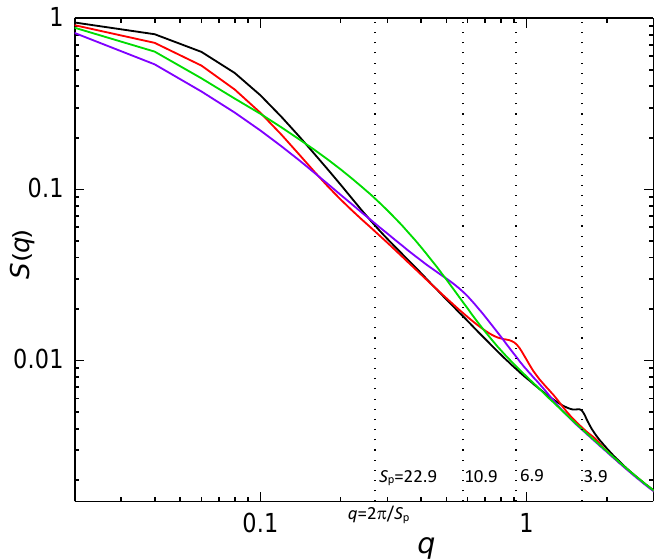
Figure 10. Structure factor for a flexible block of a block copolymer in an array of nanoposts with constant passage width w = 2 and variable S p and d p . The vertical dashed lines indicate the increased segment correlations at the length scale S p , the effective distance between the axes of two adjacent interstitial volumes.